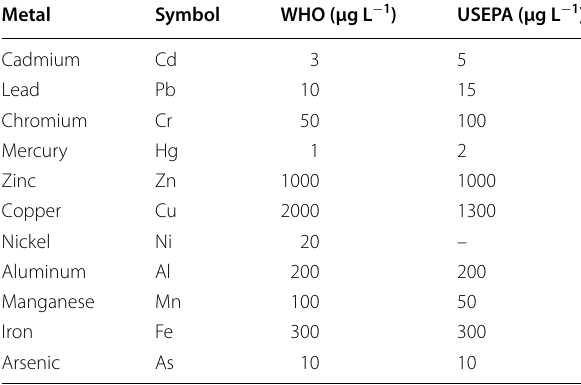
Table 1 Upper concentration limits for heavy metals in